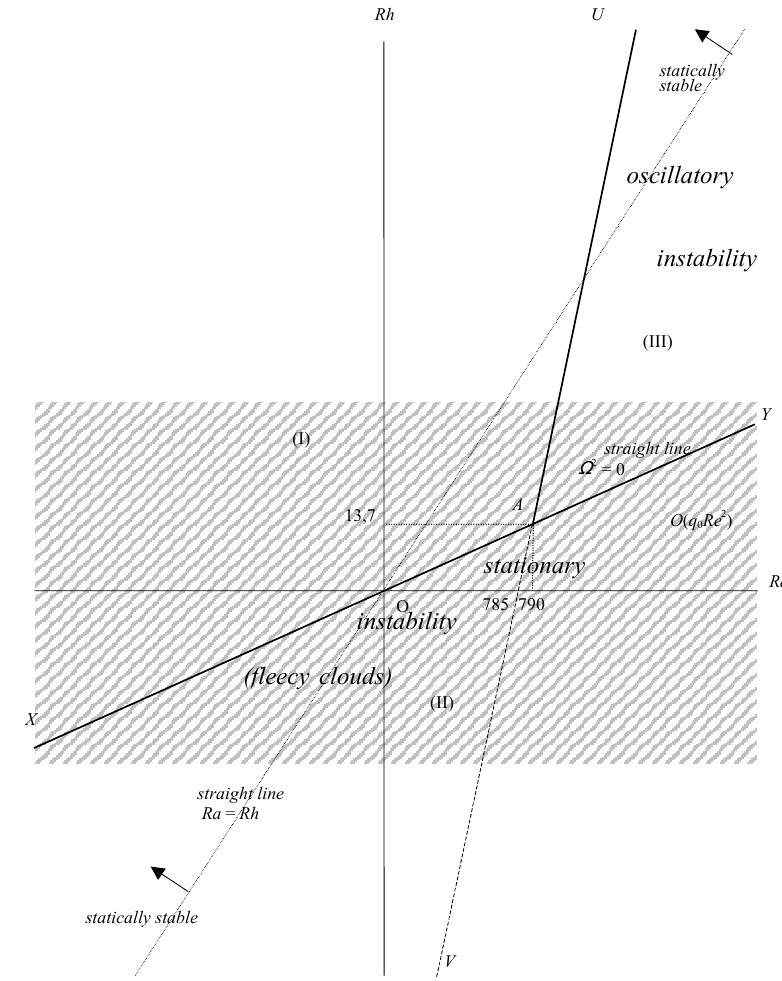
Fig. 1. Linear instability diagram of moist-saturated air in the ( R a ,R h ) plane. In order to exhibit the different regions more explicitly, the scales are not respected in this figure. The realistic instability is located in the shaded region R h = O(q 0 R 2 e ) , so that the polycritical point may be either inside or outside the instability domain. The straight line R a = R h delineates the statically stable region. The numerical values chosen for determine the polycritical point A are (units M.K.S.A.): L 0 = 2600 10 3 J/kg, 2 0 = 288 ◦ K, c pv = 1004J/(kg. ◦ K), R v = 464 J/(kg. ◦ K), R g = 287J/(kg. ◦ K), S = S ∗ /q 0 = 721, P r = 0 , 76, q 0 = 10 − 3